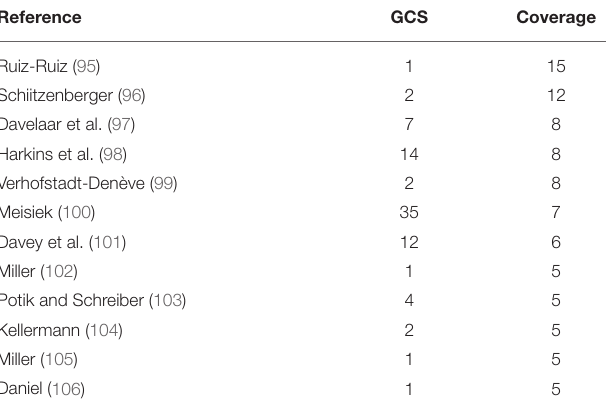
TABLE 5 | Citing papers belonging to cluster